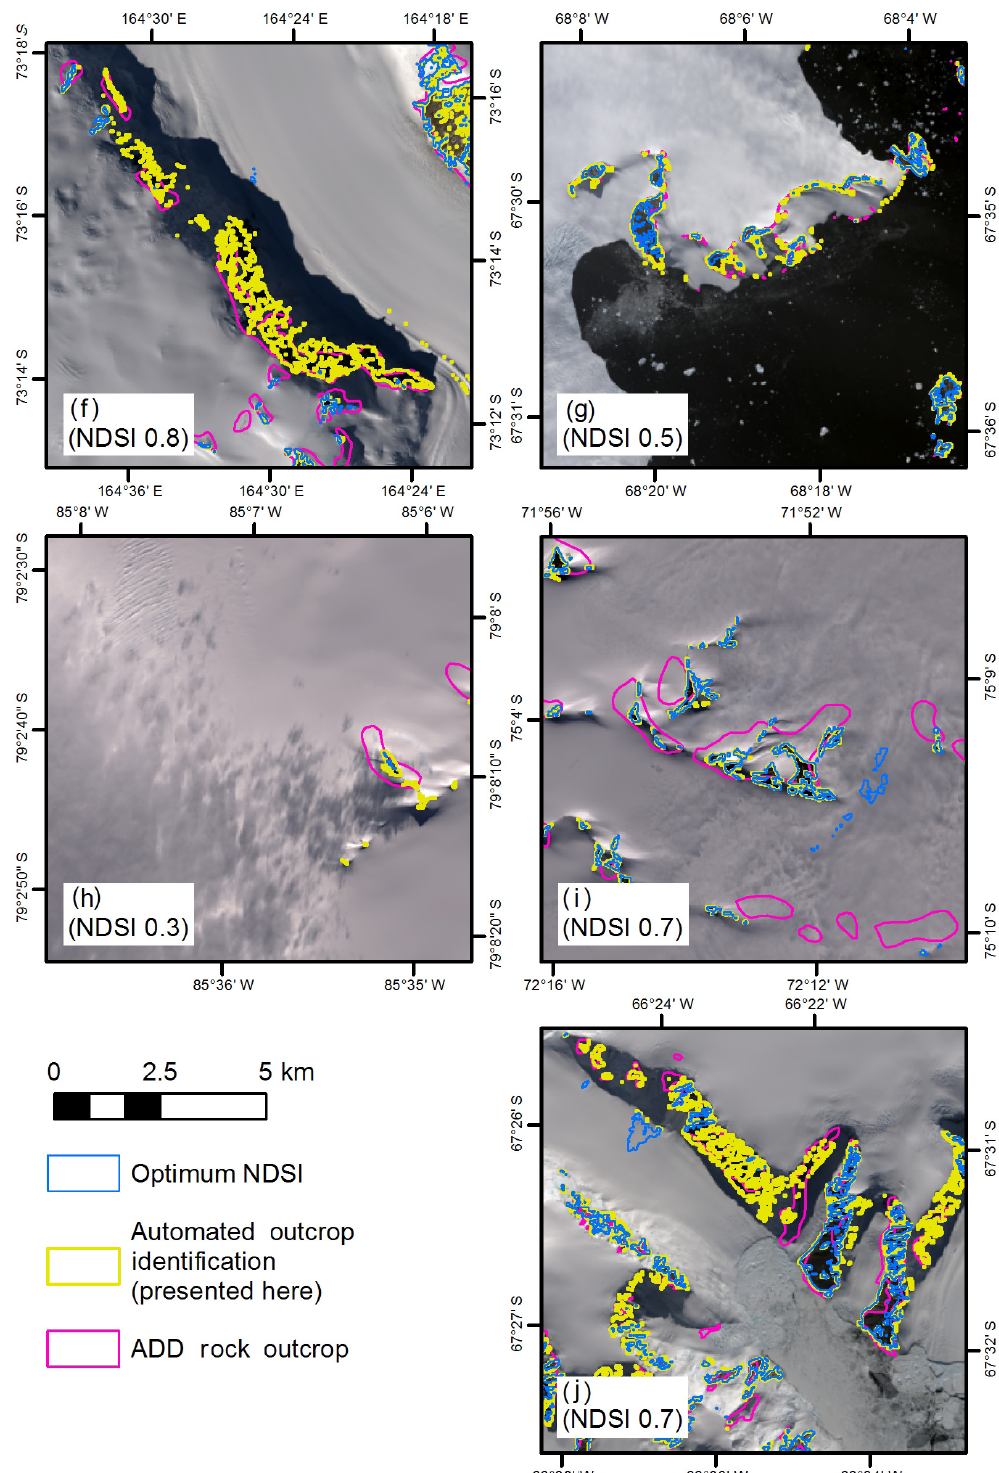
Figure 8. Images used for the quality assessment overlain by the three alternative methodologies and datasets: pixels extracted using optimum NDSI thresholds for each image (NDSI threshold values shown in brackets); pixels extracted using the new methodology presented here; and the extents of the current ADD rock outcrop map. Enlargements of these images can be downloaded from the Supplement. Scene locations are indicated in Fig.